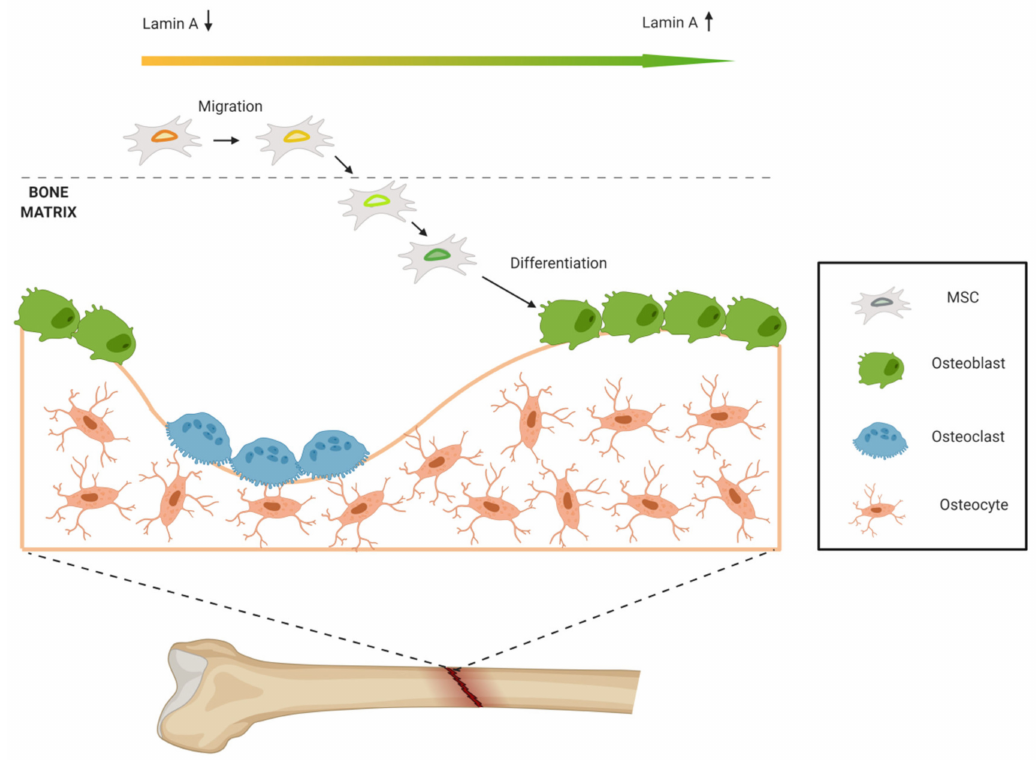
Figure 3. MSCs’ migration and di ff erentiation. Lamin A / C levels in MSCs vary according to the microenvironment. Low lamin A / C levels are needed for migration, while high levels are required for osteogenic di ff